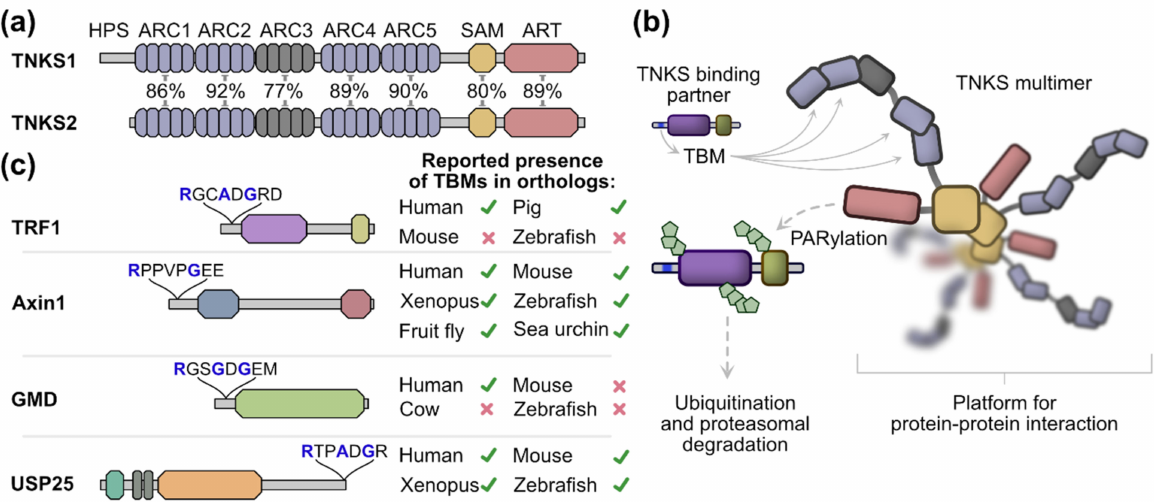
Figure 1. Tankyrase domain organization, function and binding partners. ( a ) Schematic representa- tion of the domain architecture from human TNKS1 and TNKS2. The sequence identities between domains of TNKS1 and TNKS2 are shown in percentages. TNKS1 has a Histidine, Proline and Serine- rich region (HPS) at the N-terminus, which is not present in TNKS2. ( b ) A model of TNKS function. TNKSs form multimers mediated by the SAM domain and interact with proteins that contain TNKS binding motifs (TBMs), which bind to the ARC1, 2, 4 and 5 domains of TNKSs. Many binding partners are PARylated by TNKSs, which leads to their subsequent ubiquitination and proteasomal degradation. Additionally, TNKSs may also act as scaffolding proteins by providing a platform for protein–protein interactions. ( c ) Examples of tankyrase binding partners TRF1, Axin1, GMD and USP25. The TBM sequence for each binding partner is shown. Crucial residues for the interaction with TNKS ARC domains are highlighted in blue. Previously reported presence or absence of the TBM in orthologs from other species is shown for TRF1 [23], Axin1 [10], GMD [24] and USP25